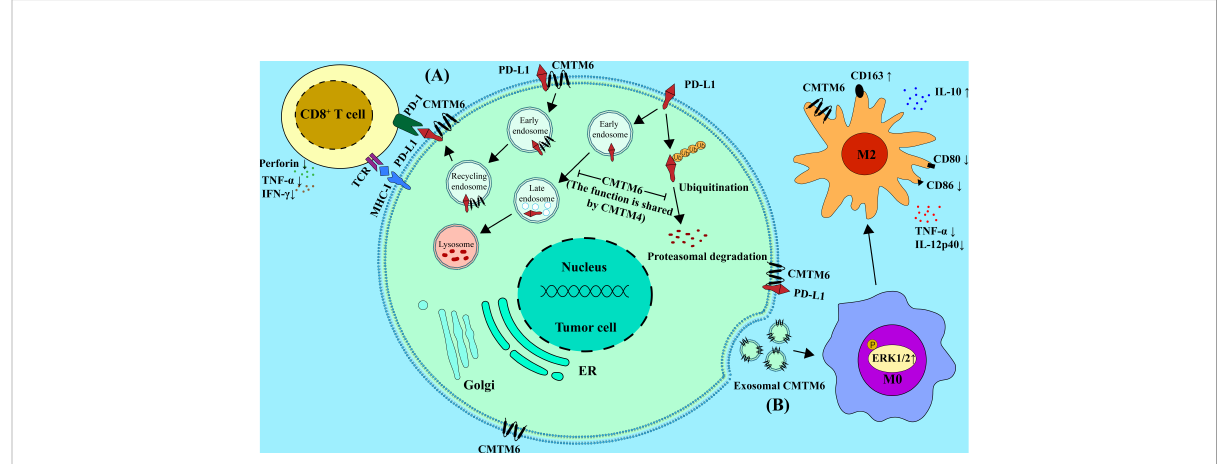
FIGURE 1 Mechanisms of CMTM6 and CMTM4 in regulating the function of the immune cells in TME. (A) CMTM6 protein can stabilize the PD-L1 protein on tumor cell, and this function is shared by CMTM4. CMTM6 co-localizes with PD-L1 at the plasma membrane and in recycling endosomes, where it inhibits PD-L1 being targeted for lysosome-mediated degradation. Moreover, CMTM6 inhibits the ubiquitination of PD-L1. CMTM6/4 enhancedPD-L1-mediated T cell suppression through the above pathways, as indicated by decreased secretion of perforin, TNF- a and IFN- g . (B) CMTM6 promotes M2 macrophage polarization through exosome shuttling by activating ERK1/2 signaling in M0, whereas it inhibits M1 macrophage polarization. It is mainly manifested by the up-regulation of M2-speci fi c markers such as CD163 and IL-10 and the down- regulation of M1-speci fi c markers such as CD80, CD86, TNF-a and